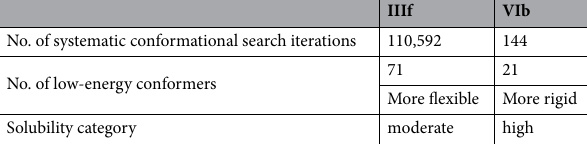
Table 9. Computed physiochemical properties of ( IIIf ) and ( VIb